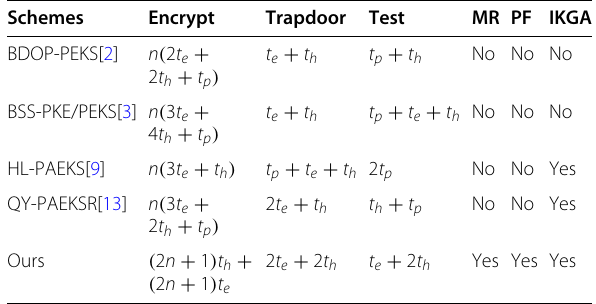
Table 1 Computation cost comparison